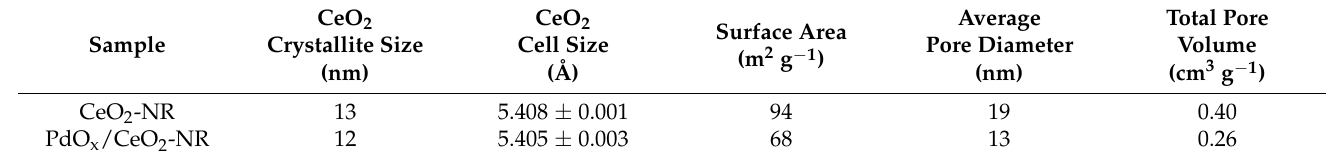
Figure 1. X-ray diffraction (XRD) patterns of the CeO 2 -NR and PdO X /CeO 2 -NR samples.